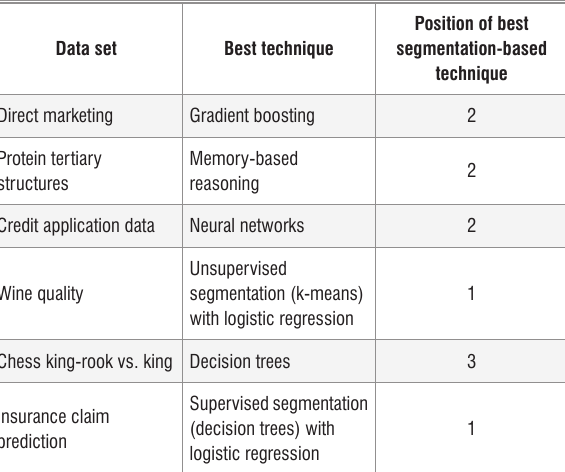
Best Gini Summary of results of alternative techniques compared to seg- Rank obtained men tation-based technique Data set Best technique